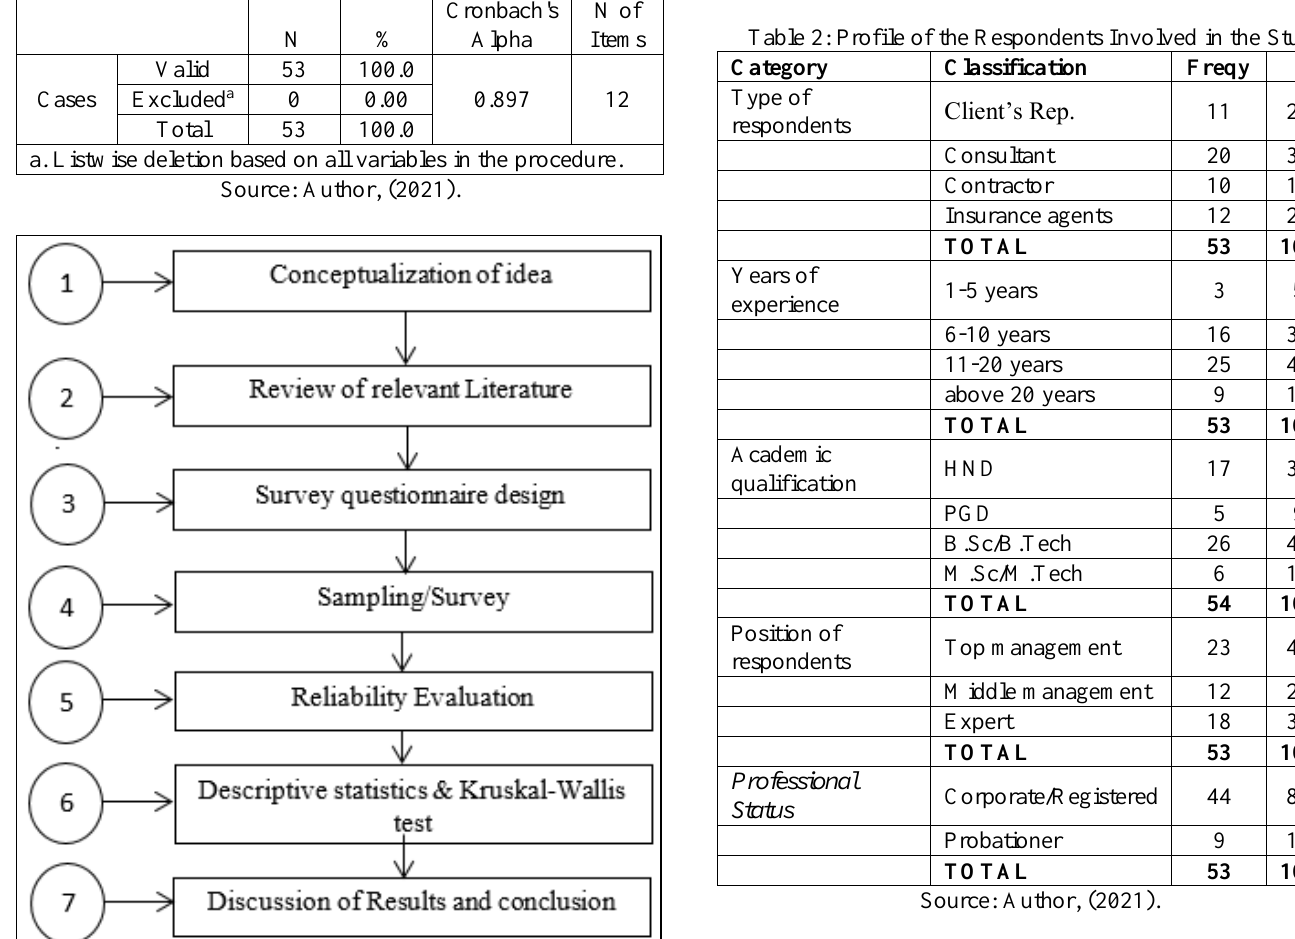
Table 1: Reliability Evaluation. Case Processing Summary